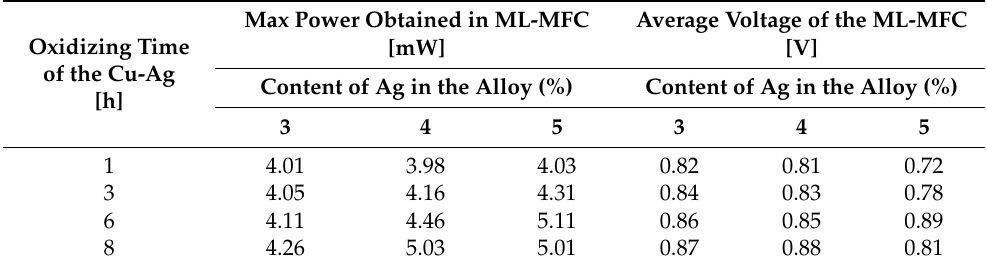
Table 2. Power and voltage (maximum value) obtained in ML-MFC (powered with PYWW). Cath- ode: Cu-Ag (foam form) oxidized for 1 – 8 h.